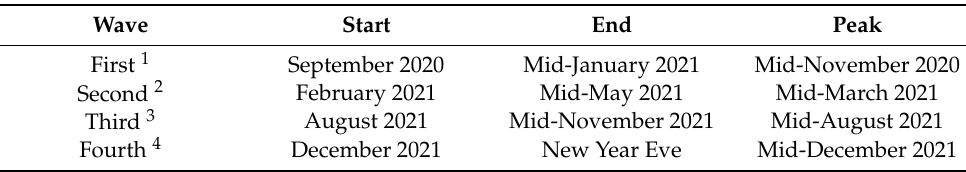
Table 1. A summary about the pandemic waves in